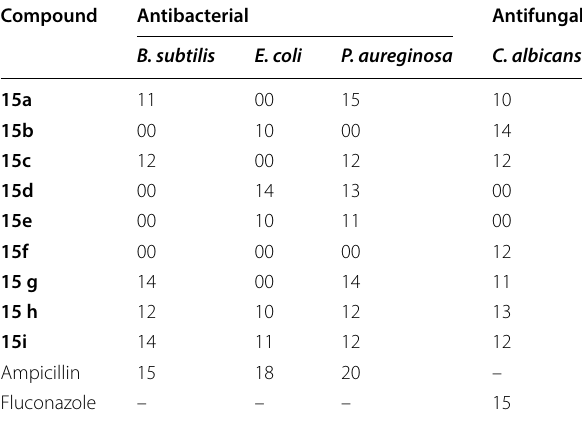
Table 4 Antimicrobial